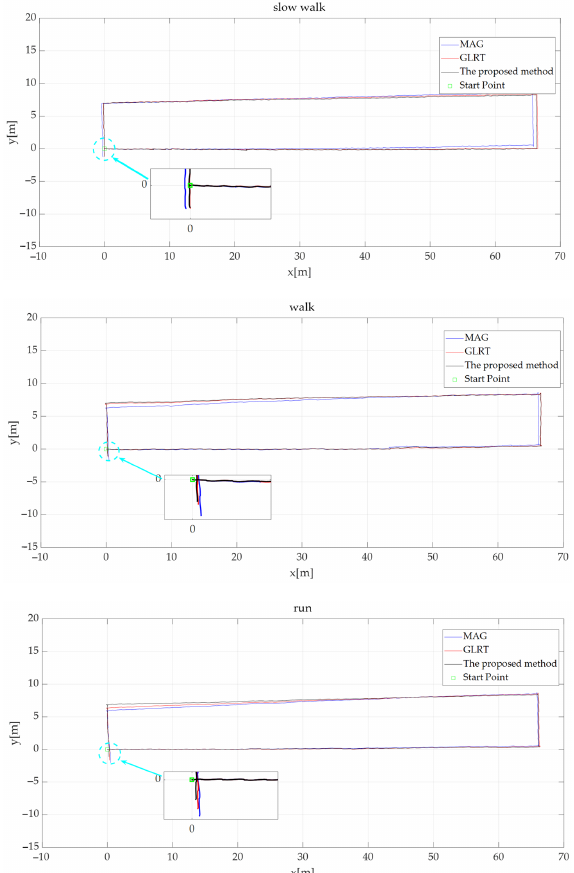
Figure 6. Trajectories obtained by using different zero velocity detectors under three motion modes.